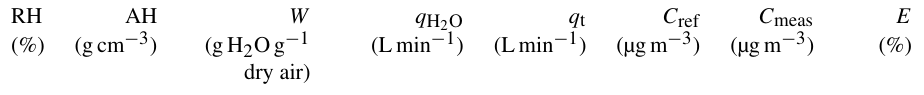
) and the flow rate from the benzene reference gas 2 O